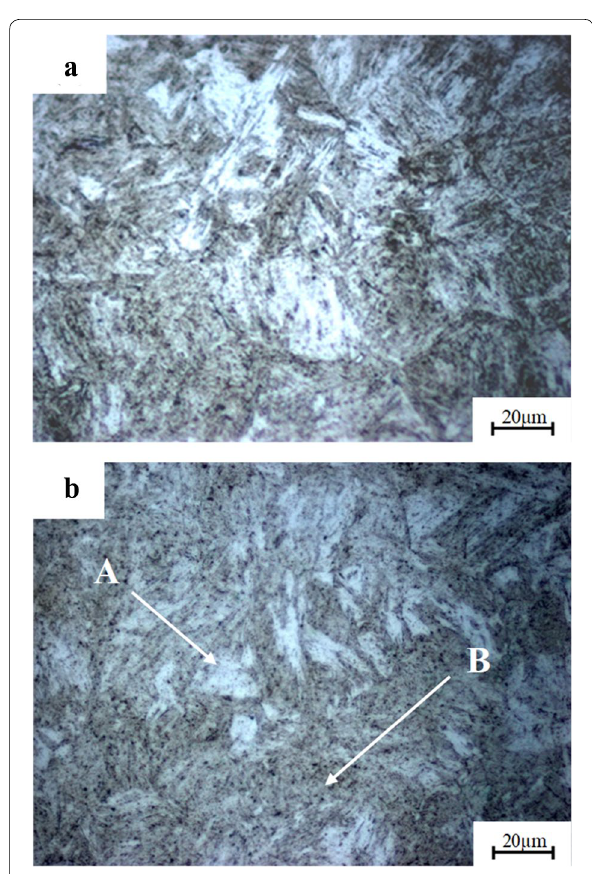
Figure 12 Microstructure of a U-cap part after Q&P hot stamping: a flange; b